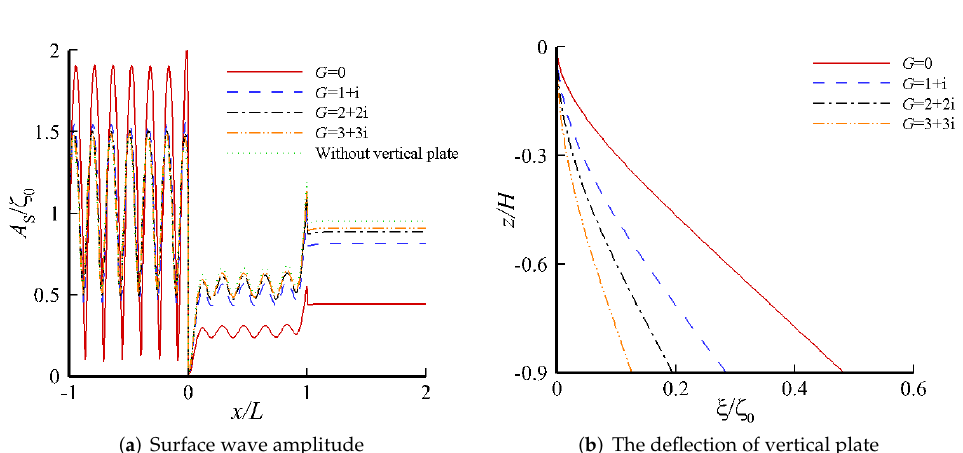
Figure 9. Wave amplitudes A S ( x ) and deflection of vertical plate ξ ( z ) for the different G